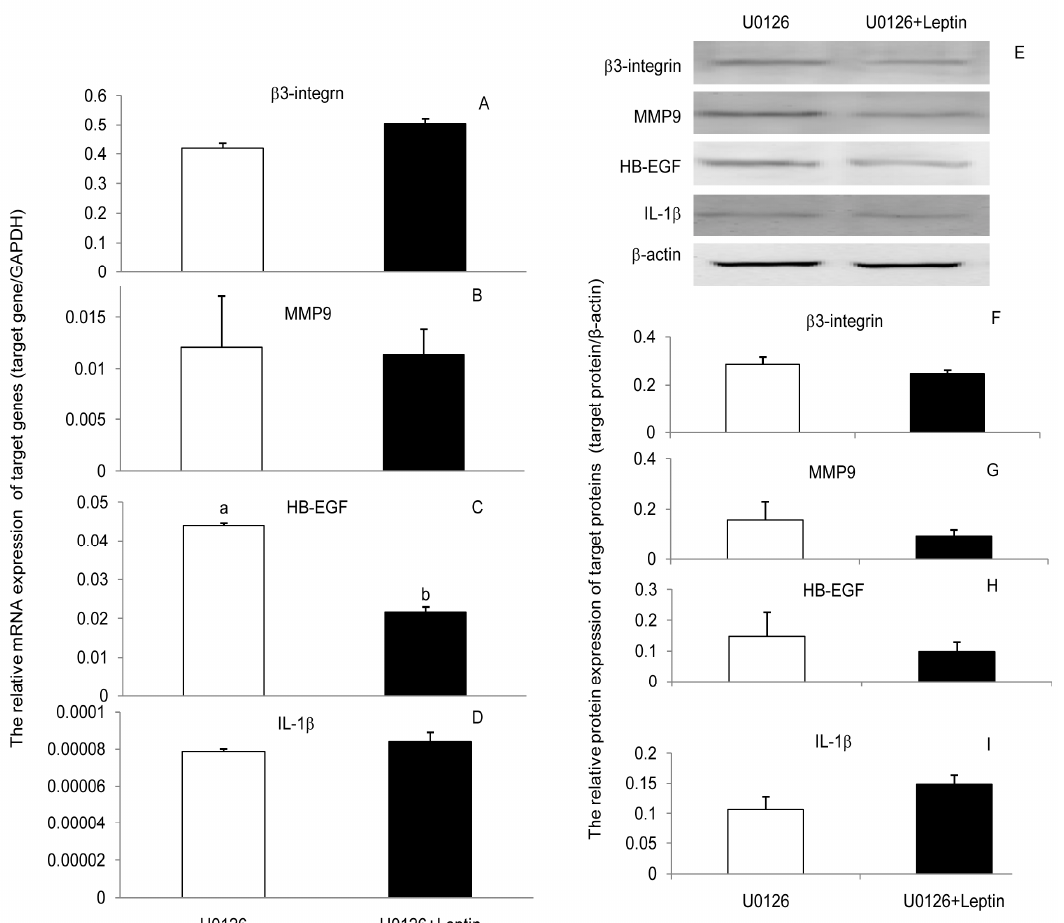
Figure 5. Effect leptin and U0126 (inhibitor of MAPK) on the expressions of β 3-integrin, MMP9, HE-EGF, and IL-1 β mRNA and proteins in primary porcine endometrium epithelial cells (PEECs). ( A – D ): The relative mRNA level of β 3-integrin, MMP9, HE-EGF, and IL-1 β in response to leptin and U0126 as determined by RT-PCR. GAPDH was used as the internal control. ( E – I ): The relative protein expression of β 3-integrin, MMP9, HE-EGF, and IL-1 β in response to leptin and U0126 as determined